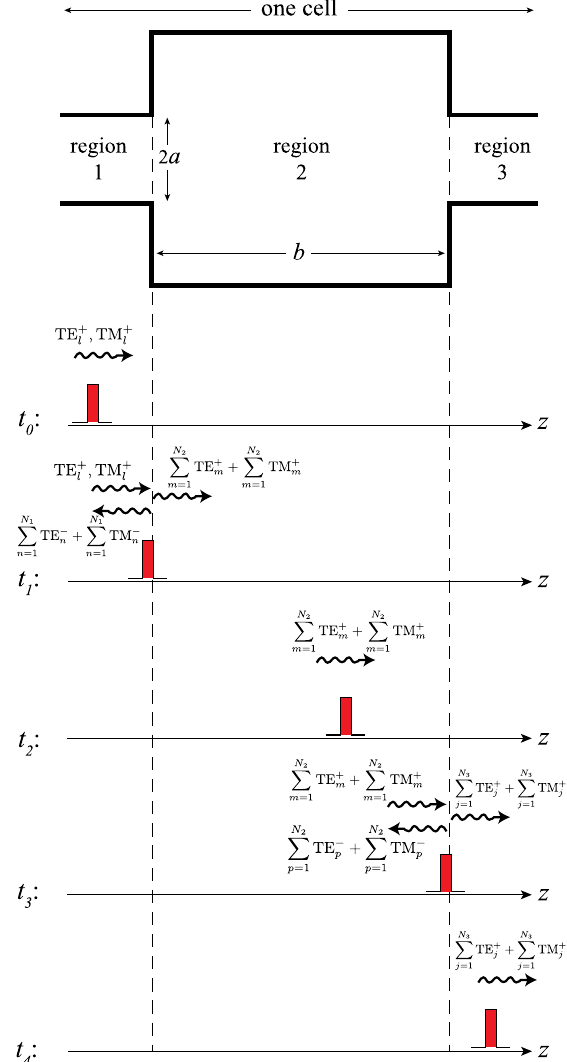
FIG. 3. A qualitative sketch of a short THz pulse traveling through the oversized cell, with indicative forward and backward mode expansions at each boundary plane within the cell. For clarity, the pulse (in red) is shown at different moments in time. At t 0 , a forward-traveling wave is incident onto the cell. At t 1 , the wave reaches the first discontinuity and we generally have a forward mode and a backward scattered-mode expansion in region 1, along with a forward scattered – mode expansion in region 2 (due to the shortness of the pulse, no backward reflections exist yet in region 2). At t 2 , the forward wave continues through region 2, and at t 3 , the second discontinuity is met: again, we generally have forward and backward scattered- mode expansions in region 2 and only a forward scattered – mode expansion in region 3. At t 4 , forward traveling waves propagate in region 3 toward the cell ’ s exit, and the cycle repeats through the next cells. A key assumption made in the forward-scatter high- frequency analysis under consideration (see the main text) is that we can expand the wave in forward modes only, ignoring the backward reflections as a first approximation, which turns out to be a good approximation at the high-frequency